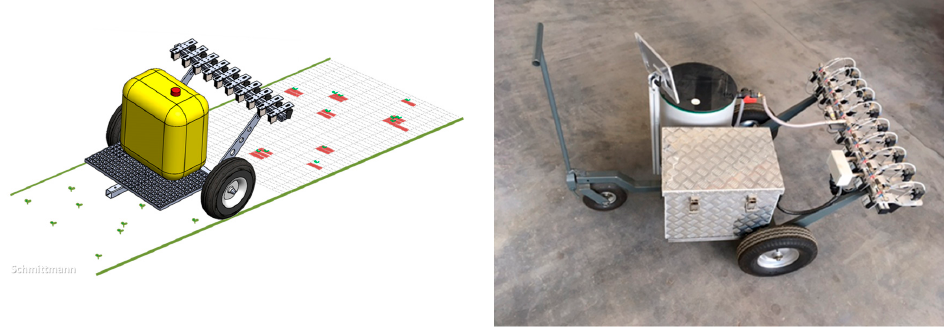
Figure 5. Concept ( Left ) and prototype ( Right ) of the mobile field carrier with spraying device.